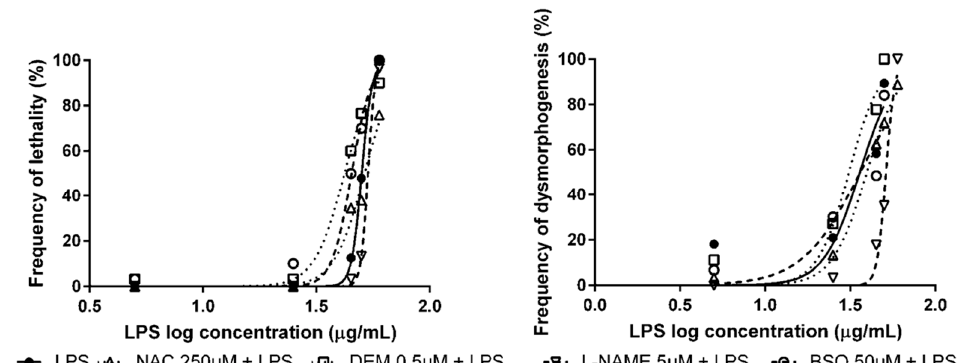
Figure 3. Concentration–response curves for lethality and dysmorphogenesis of lipopolysaccharides of Escherichia coli 0111:B4 (LPS) alone or in combination with modulators of antioxidant status.